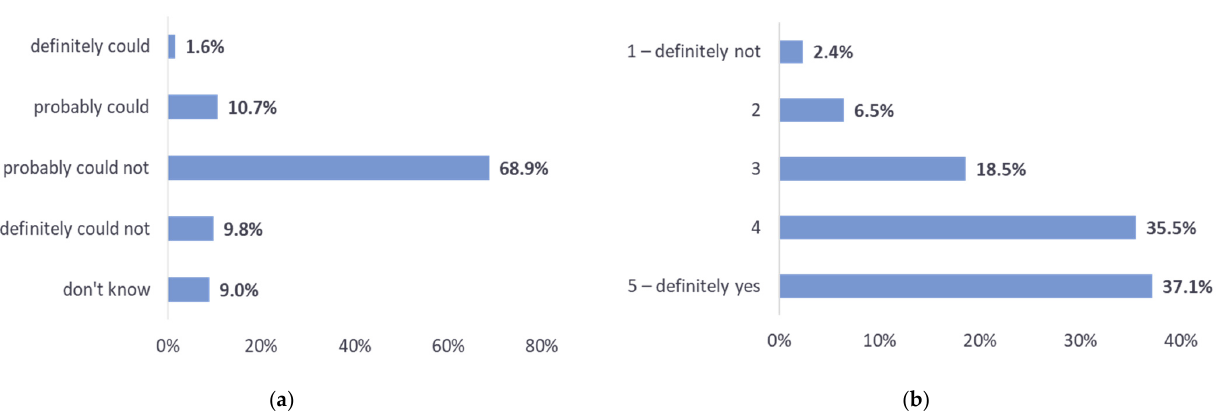
Figure 6. Opinions on INFOBot. ( a ) Could it have any negative impact on one’s comfort at work? ( b ) Would one be open to having it in one’s company?